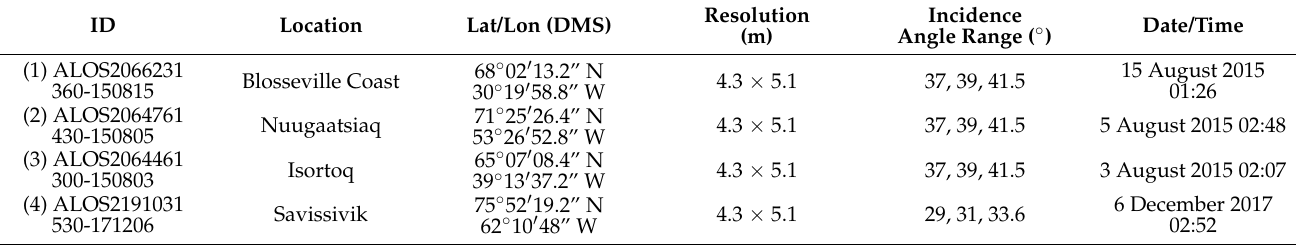
Table 1. ALOS-2/PALSAR-2 image properties. Latitude and longitude use centre degrees, minutes, seconds (DMS) coordinates. Incidence angle range is min, centre, and max to indicate the near, mid and far range of each image. Ground resolution is ALOS-2 quad-polarimetric mode. Time is UTC. Note that Savissivik was acquired in winter months.